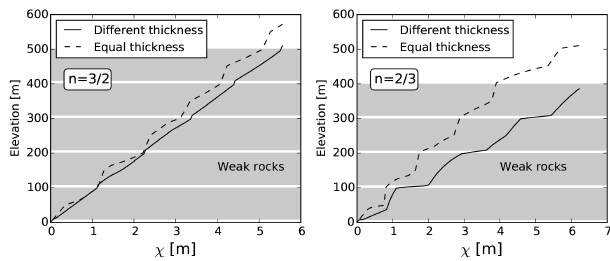
Figure 7. The influence of relative layer thickness on slopes in con- tinuity steady state. If the relative thickness of the strong and weak layers is changed, the slopes that are far from base level in both rocks adjust correspondingly (solid lines), as predicted by continu- ity steady state. Grey bands depict the locations of weak rocks in the differing thickness model. The dashed lines depict channel profiles for simulations with equal layer thickness but the same erosional parameters. Increasing the weak layer percentage reduces topogra- phy